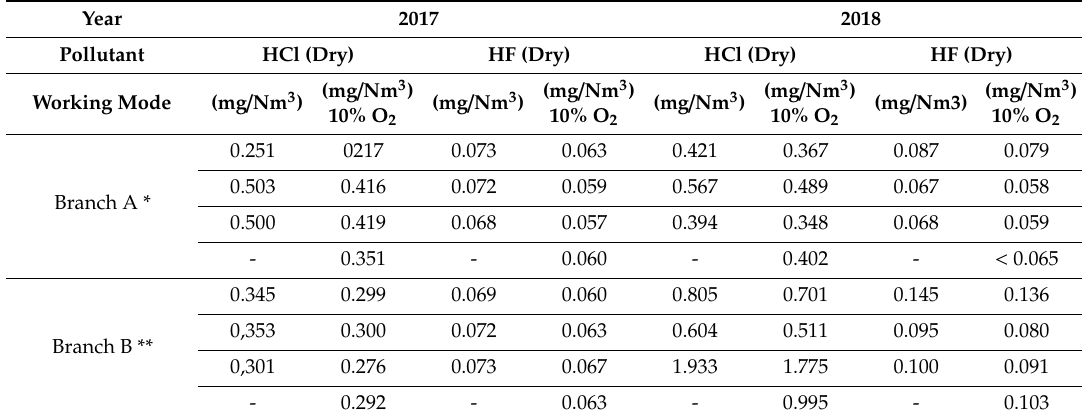
Table 4. Measurement results of HCl and HF of the rotary kiln at the second factory for 2017 and